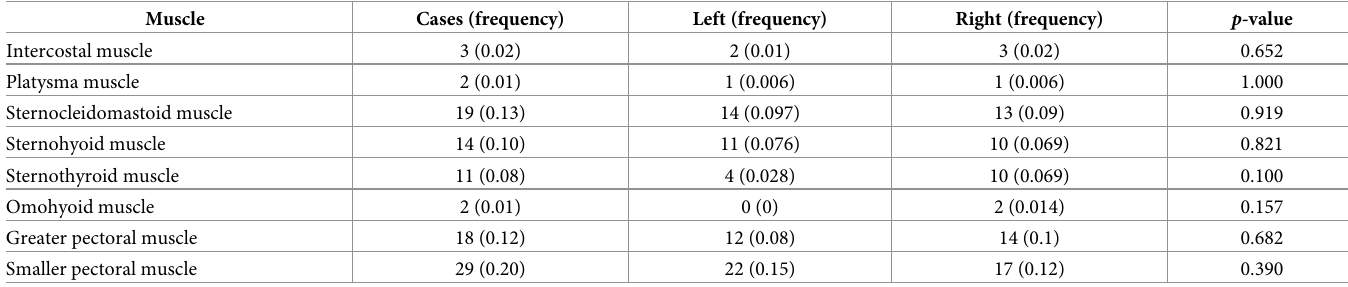
Table 1. Muscles with intramuscular